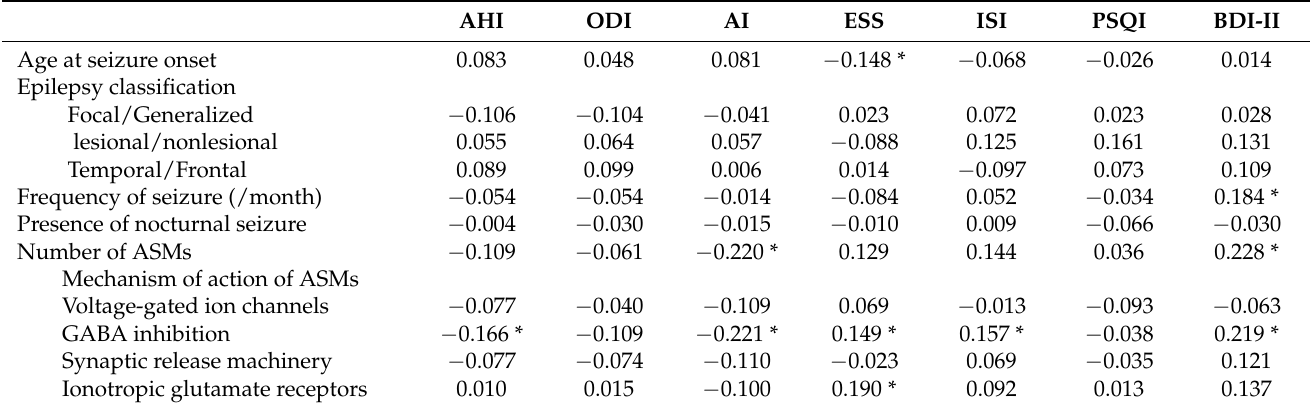
Table 4. Correlation between epilepsy-related factors and polysomnography